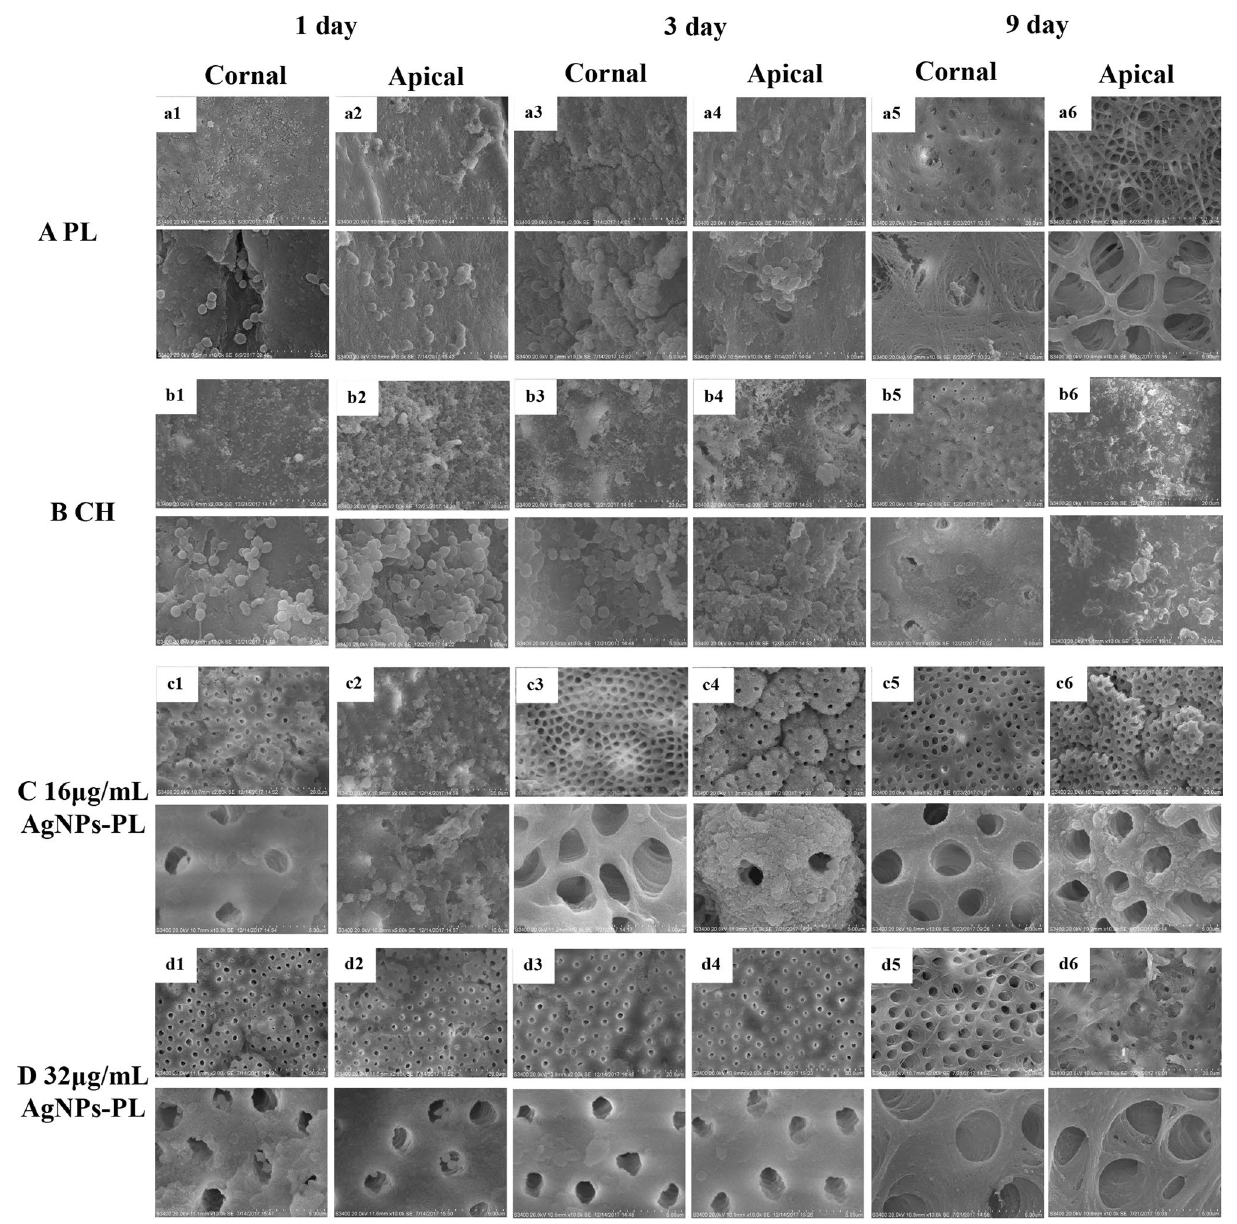
Figure 7. Representative field emission scanning electron microscopic images showing colonization of E. faecalis on root canal walls (the first row of each group × 2000 magnification; the second row of each group × 10,000 magnification). ( a1 – a6 ) representative image showing growth of E. faecalis on coronal and apical part of root canal wall in PL group for 1, 3, 9 days; ( b1 – b6 ) representative image showing growth of E. faecalis on coronal and apical root canal wall in CH group for 1, 3, 9 days; ( c1 – c6 ) representative image showing growth of E. faecalis on coronal and apical root canal wall in 16 μg/mL AgNPs-PL group for 1, 3, 9 days; ( d1 – d6 ) representative image showing growth of E. faecalis on coronal and apical root canal wall in 32 μg/mL AgNPs-PL group for 1, 3, 9